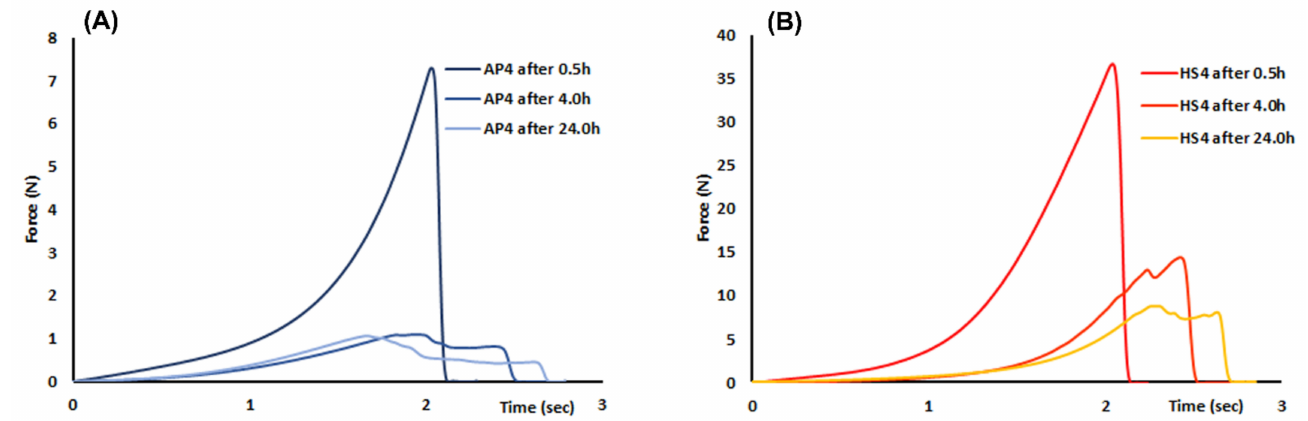
Figure 6. Mean ( n = 15) force overtime curve of the AP4 ( A ) and HS4 ( B ) gel beads incubated in Hanks’ solution for 24 h.